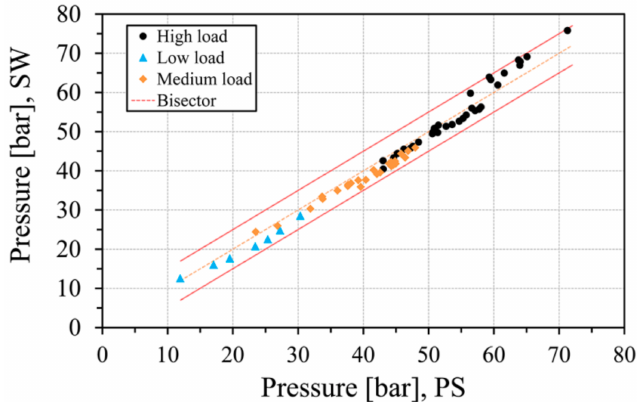
Figure 9. Maximum in-cylinder pressure evaluated by the strain washer and the pressure sensor at different operating conditions in terms of load and regime (from 3000 to 6000 rpm) on the